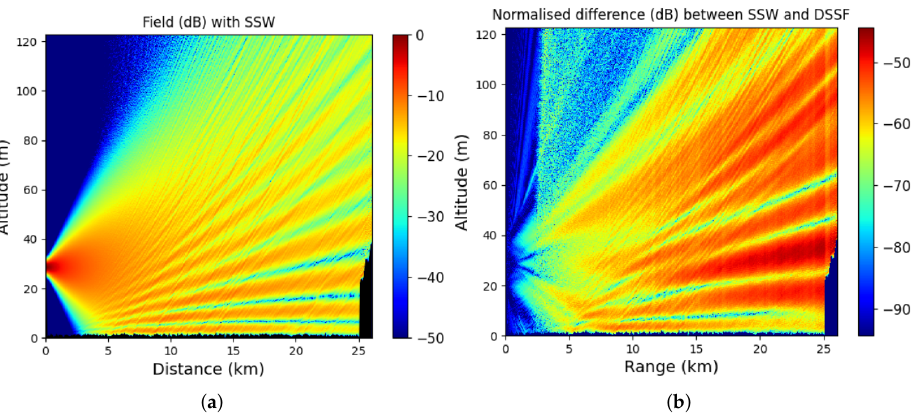
Figure 6. Propagation above a rough sea surface. ( a ) Propagation of the normalized field u (in dB). ( b ) Normalized difference between SSW and